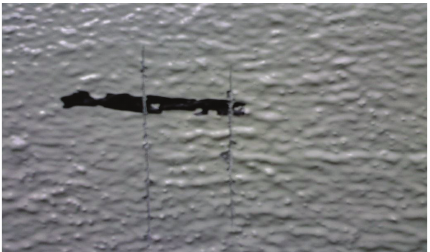
Figure 3: Concrete after maintenance.